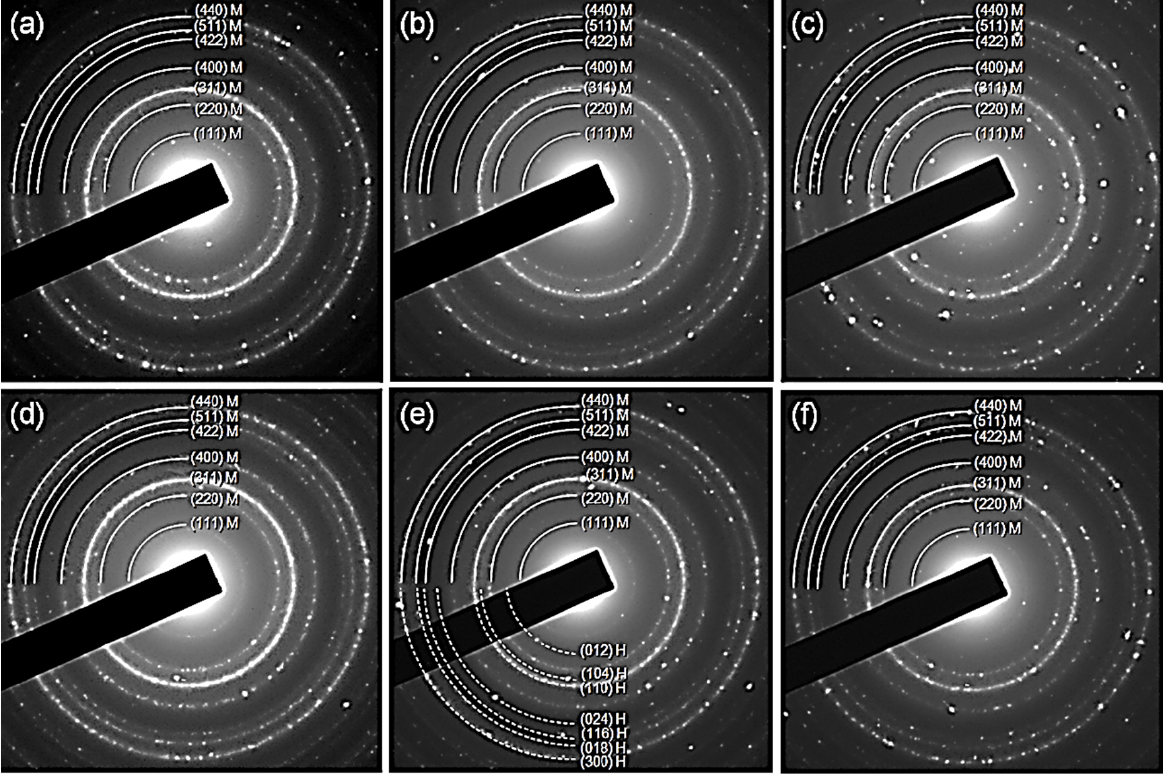
Figure 8. HRTEM image of the sample NP4: detail of atomic columns of 0.29 nm spacing corre-